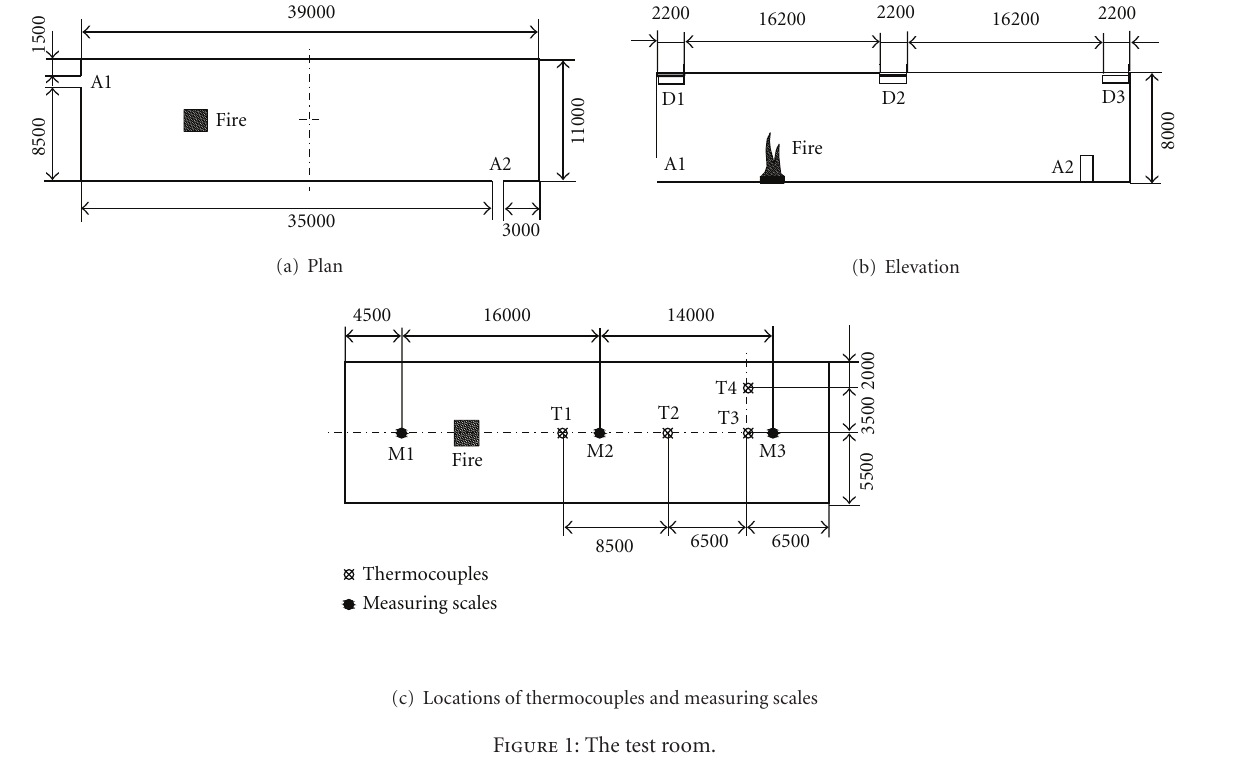
Figure 1: The test room.